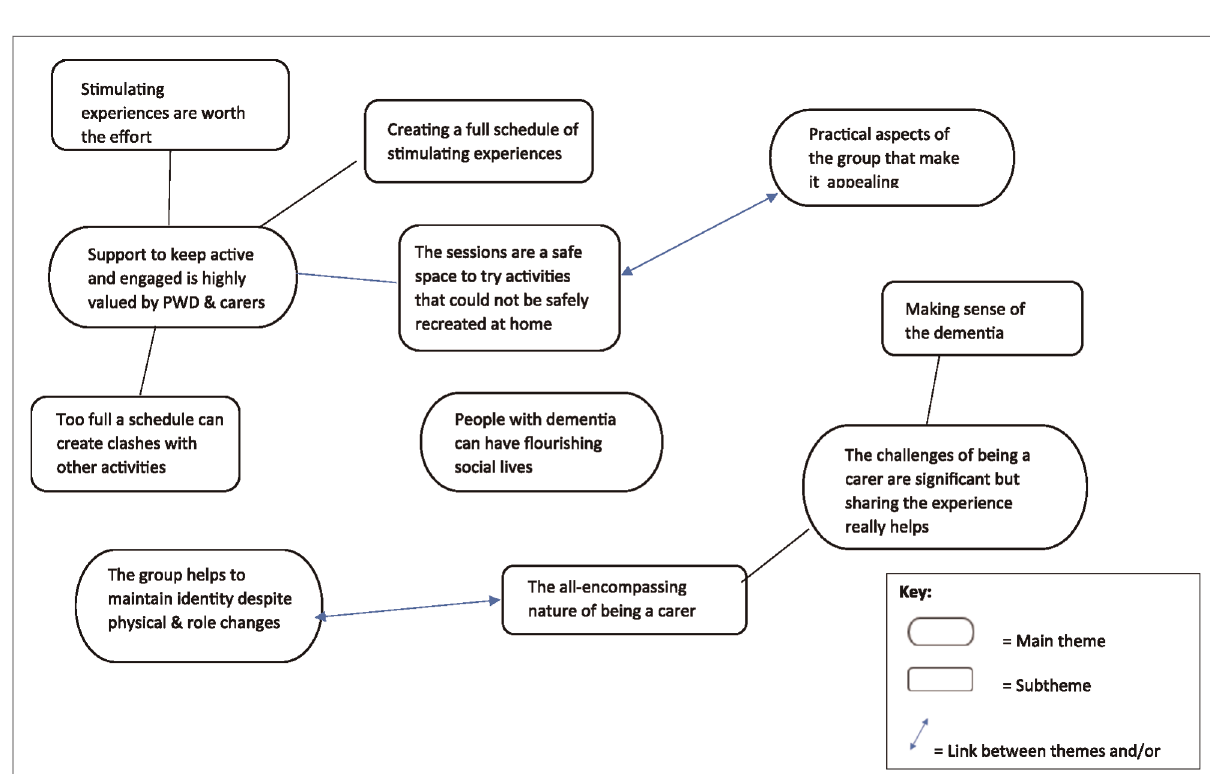
FIGURE 1 Theme map demonstrating the relationships between themes and